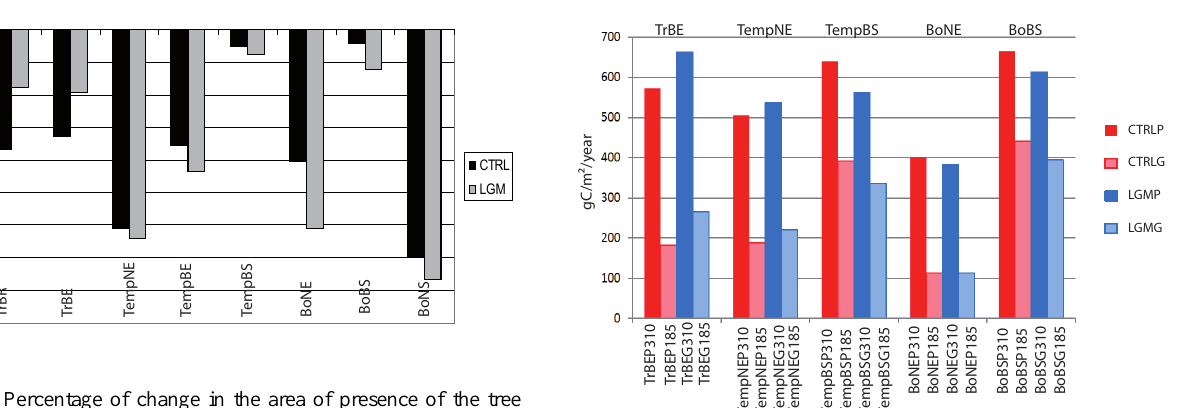
Fig. 13. Percentage of change in the area of presence of the tree PFT (fraction exceeds 1%) when the CO 2 is decreased from 310 to 185ppm and the background climate is kept constant to CTRL present or LGM. Abbreviations: see Table 1. Fig. 14. Global annual mean NPP for the static simulations with